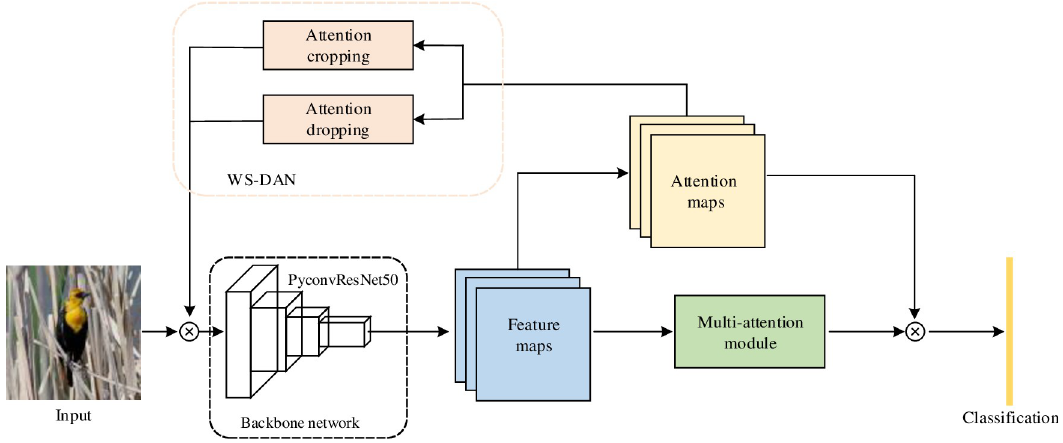
Fig 1. The overall architecture of the